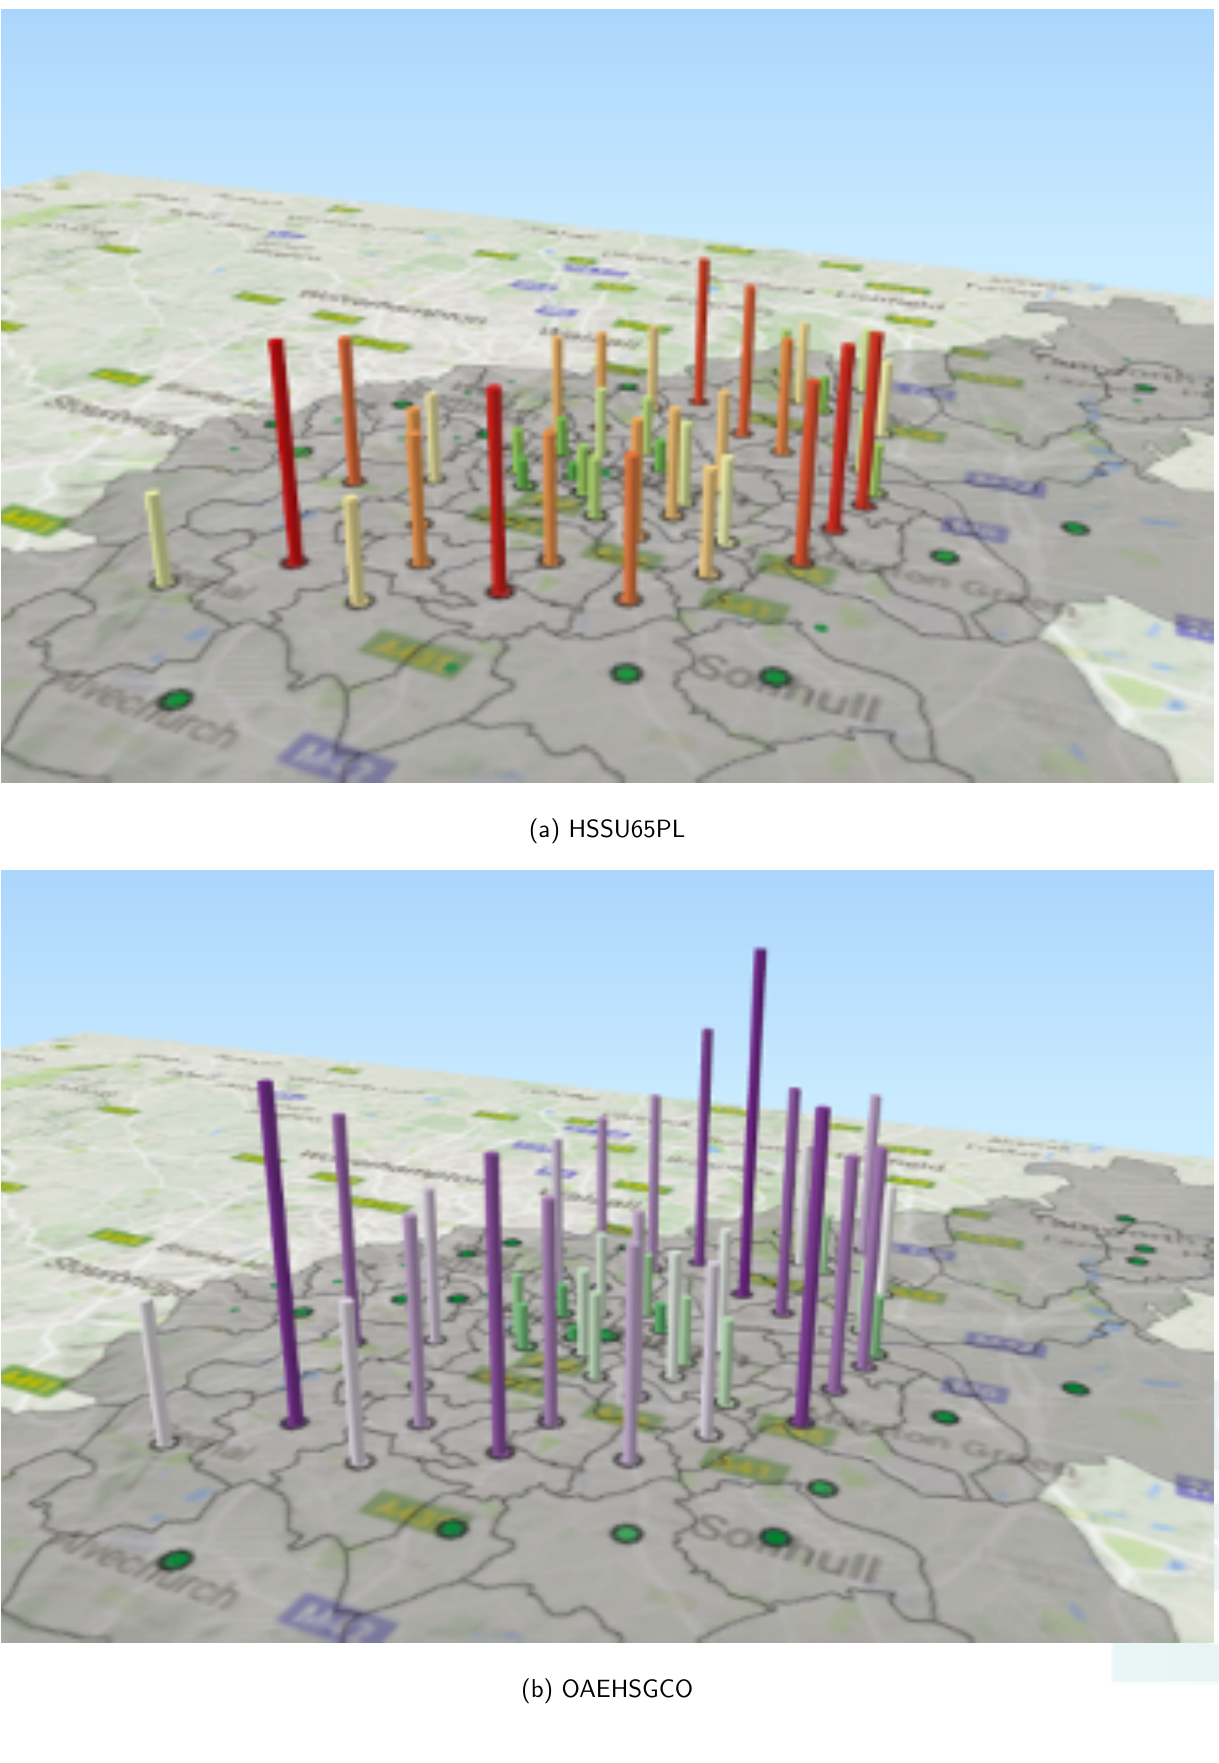
Figure 7: Geographical dispersal of the OAEHSGCO and HSSU65PL service elements